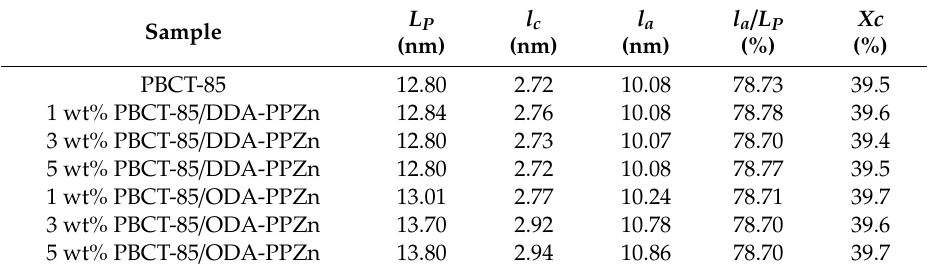
Table 2. Structural parameters and crystallinity of PBCT-85 / DDA-PPZn and PBCT-85 / ODA-PPZn obtained by X-ray scattering (SAXS) and WAXD measurements.